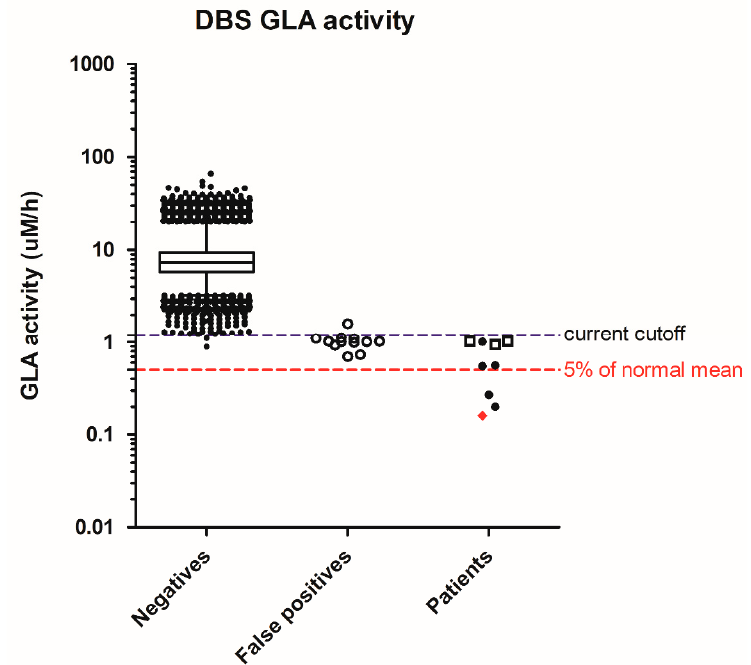
Figure 2. Distribution of screening acid α -galactosidase (GLA) activity in negatives, false positives, and patients. Whiskers: 1–99th percentile; box: 25–75th percentile; line in box: median; Diamond in patients: classic mutation; solid dots in patients: suspect type 1 mutation or confirm type 2 mutations; hollow squares in patients: c.636 + 919G>A mutation.